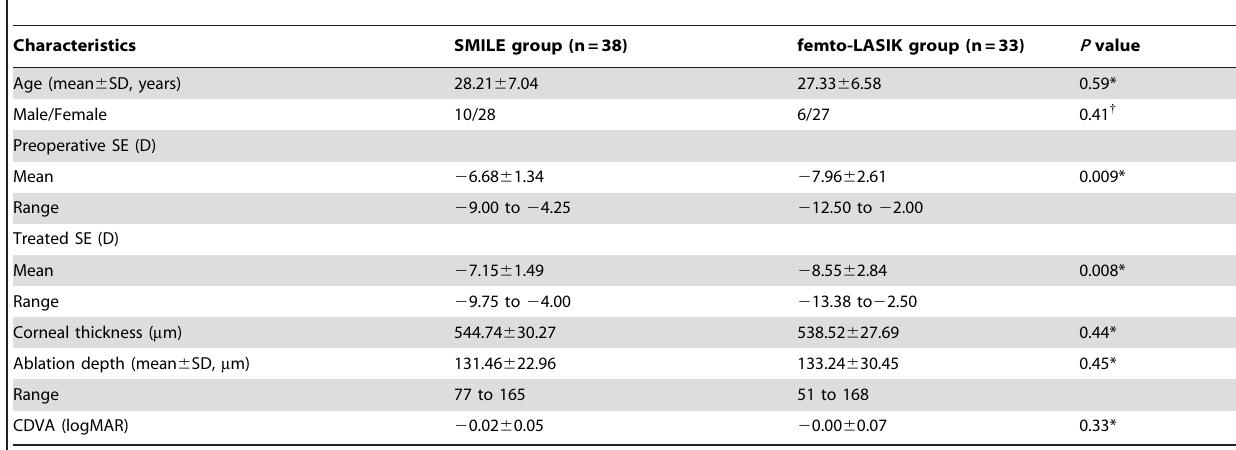
Table 2. Demographic data and preoperative characteristics of the study participants.